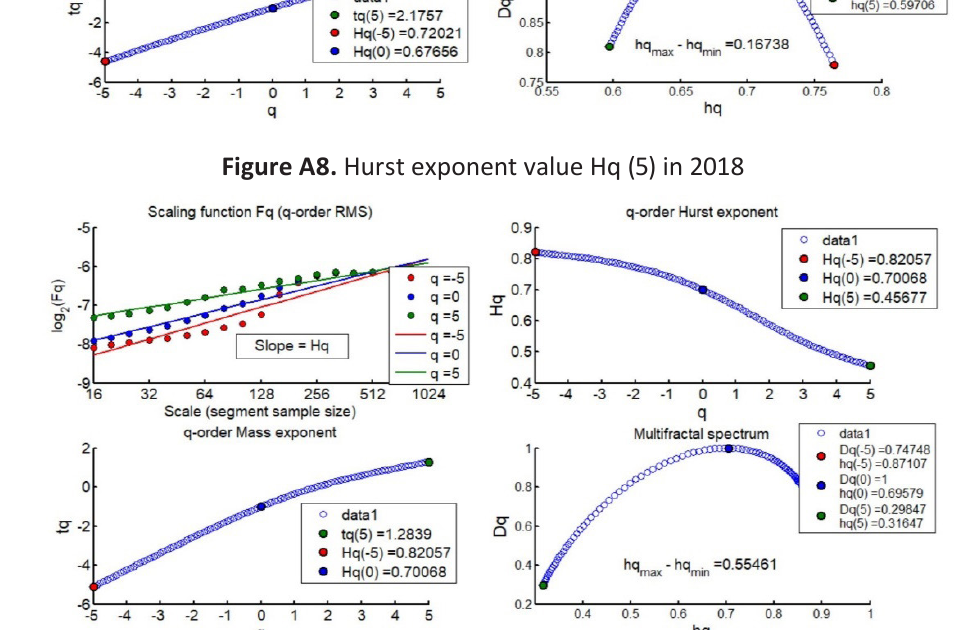
Figure A9. Hurst exponent value Hq (5) in